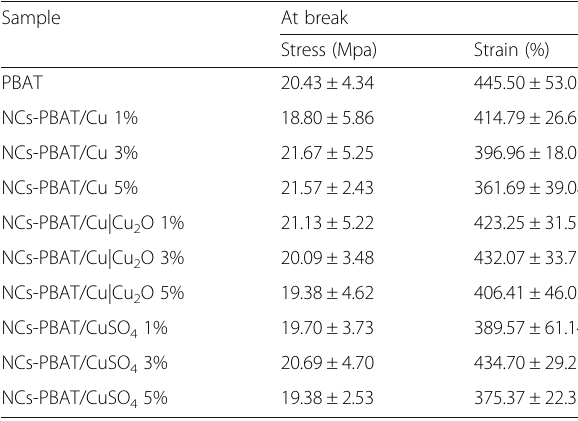
Table 2 Tensile strength of PBAT, NCs-PBAT/Cu, NCs-PBAT/